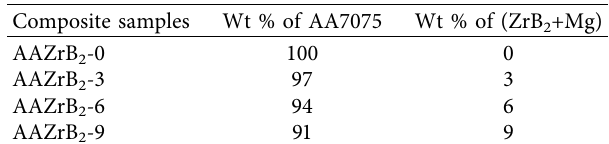
Table 3: Details on the composition of pure and aluminium alloy composite specimens.